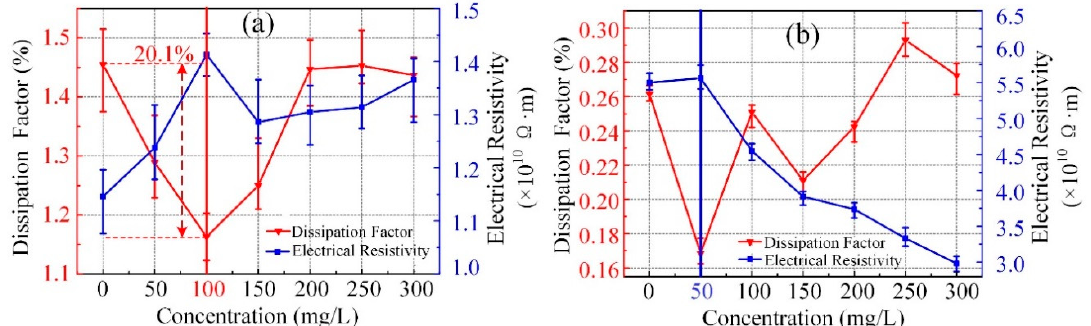
Figure 3. The variation of the dissipation factor and electrical resistivity with C 60 concentrations of vegetable insulating liquid ( a ) and mineral liquid ( b